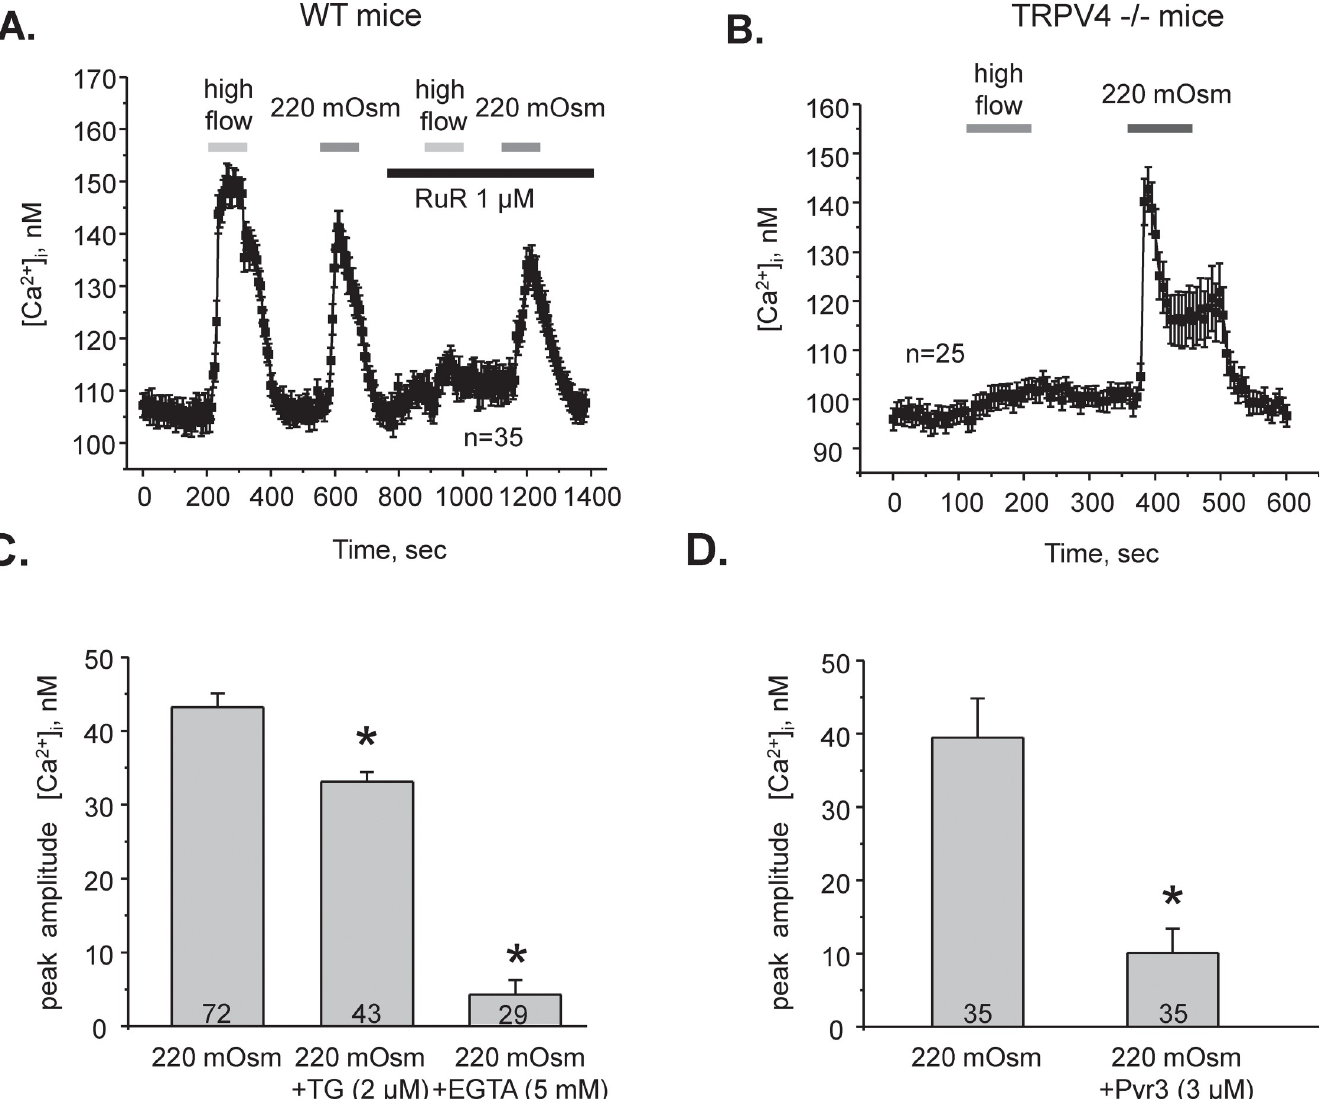
Fig 1. Hypotonic-mediated [Ca 2+ ] i signals require Ca 2+ influx via TRPC3 in CD cells. ( A) The average time course of [Ca 2+ ] i changes in response to 10X elevations in perfusion rate from 1.5 ml/min to 15 ml/min (high flow) and application of hypotonic medium (220 mOsm) in the absence and in the presence of a TRPV4 inhibitor, ruthenium red (RuR, 1 μ M) in individual CD cells within split-opened area. The treatment times are indicated by the respective bars on the top. The number of individual experiments is shown (N = 3 mice were tested). ( B) The average time course of [Ca 2+ ] i changes in response to high flow and hypotonicity in the CD cells from TRPV4 -/- mice (n–number of individual tested CD cells, N = 3 mice). (C) Summary graph of the peak amplitude of [Ca 2+ ] i responses induced by hypotonic 220 mOsm medium in the control, after pretreatment with the endoplasmic reticulum Ca 2+ pump SERCA inhibitor thapsigargin (2 μ M, 10 min), and after removing extracellular Ca 2+ (5 mM EGTA). (D) Summary graph of the peak amplitude of [Ca 2+ ] i responses induced by hypotonic 220 mOsm medium in the control and after pretreatment with a TRPC3 channel blocker, Pyr3 (3 μ M for 5 min). � —significant decrease versus 220 mOsm. N = 3 mice were used for the